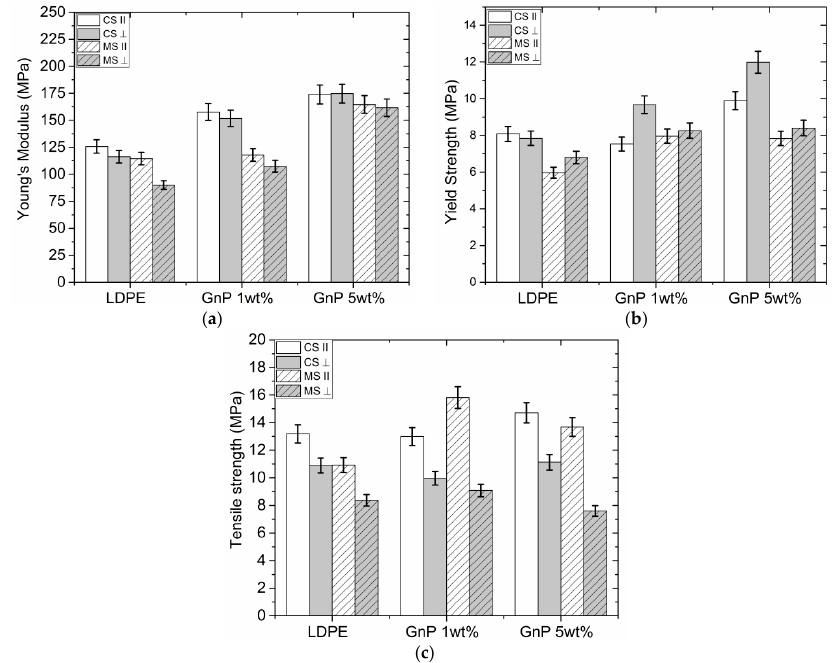
Figure 6. Comparison of Young’s modulus ( a ); Yield strength ( b , c ) tensile strength for LDPE-GnP nanocomposites.